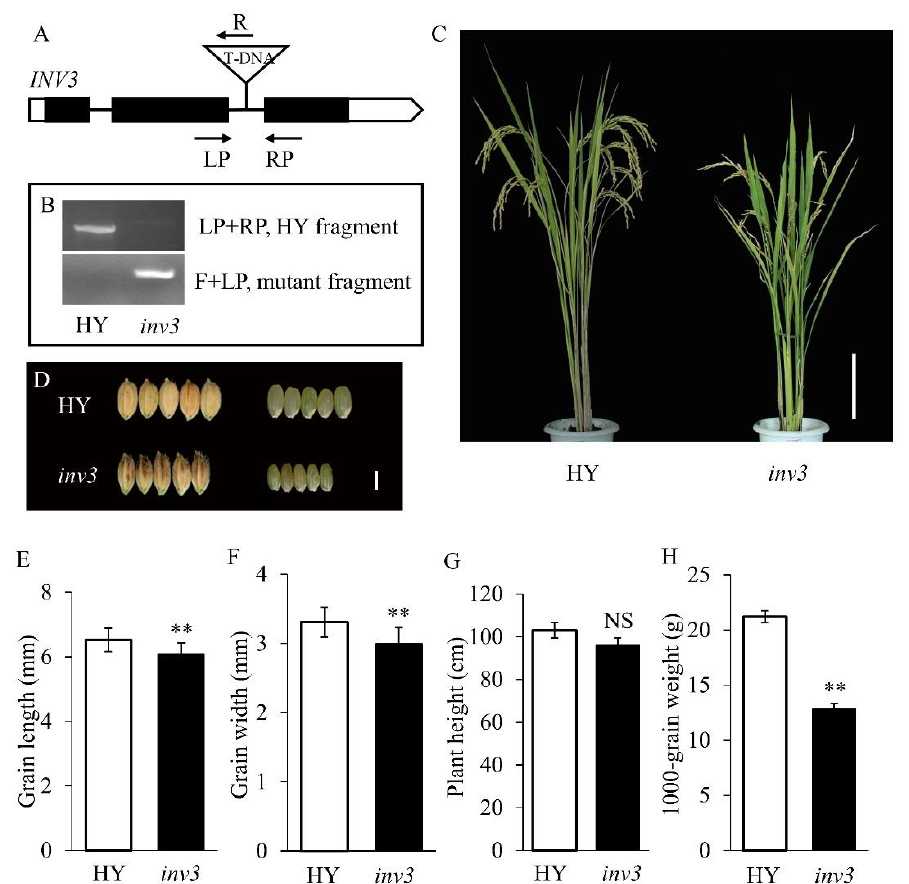
Figure 5. Phenotypic characterizations of INV3 T-DNA insertion mutant. ( A ) T-DNA insertion site of the inv3 mutant. The triangle indicates the T-DNA insertion site in the inv3 mutant. Black boxes, lines and white boxes represent exons, introns and the untranslated regions, respectively. ( B ) Gel data showing the presence of HY and inv3 alleles. ( C ) Plant comparison of HY, inv3 mutant at the maturity stage. Bar = 10 cm. ( D ) Morphology of grain shape in HY, inv3 mutant. Bar = 2 mm. ( E – H ) Statistical data of the grain length ( E ), grain width ( F ), plant height ( G ) 1000-grain weight ( H ) in WT and inv3 mutant . Data are given as means ± SD. Student’s t-test was used to generate the p values; ** and NS indicate p < 0.01 and no significant differences, respectively.